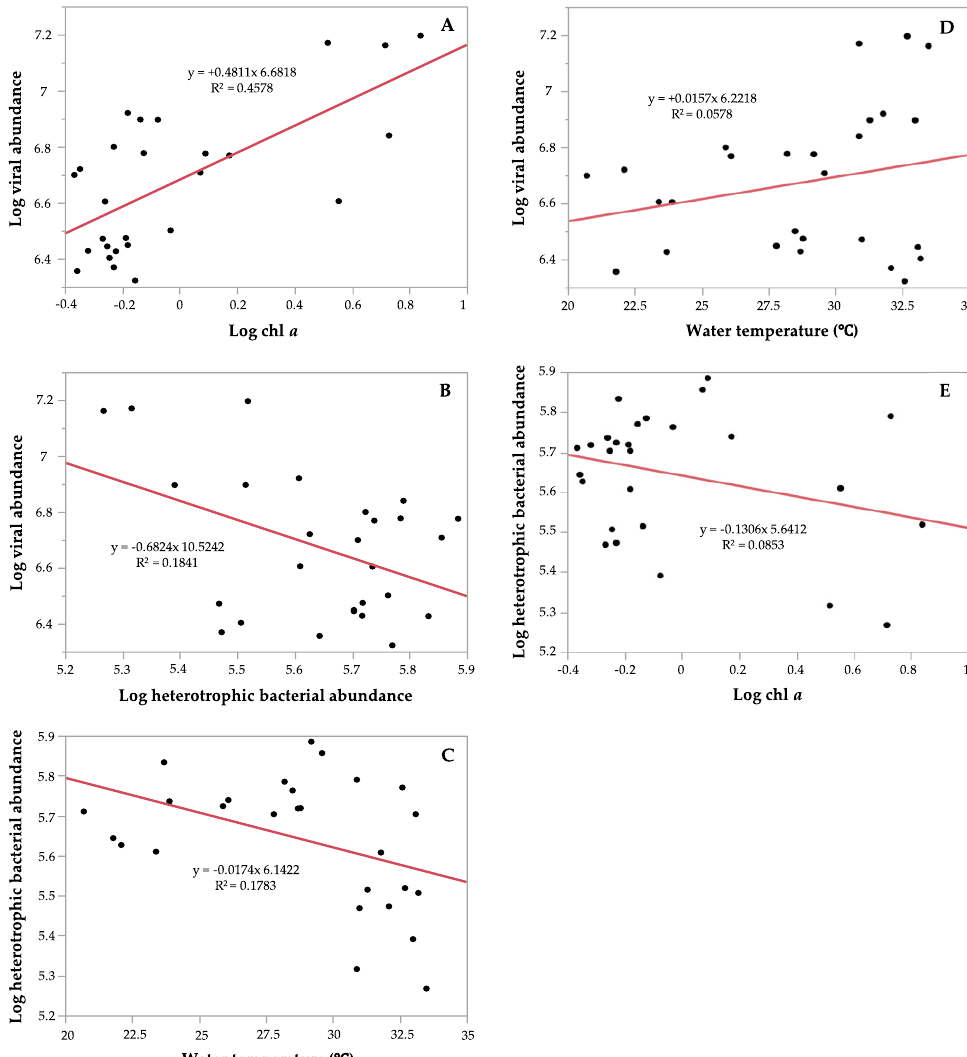
Figure 4. The significant relationships observed between viral abundance with ( A ) Log chl a concentration ( p = 0.0001), and with ( B ) Log heterotrophic bacterial abundance ( p = 0.0255); and between ( C ) Log heterotrophic bacterial abundance with water temperature ( p = 0.0282). No significant relationships between ( D ) Log viral abundance with water temperature ( p = 0.2271), and between ( E ) Log heterotrophic bacterial abundance with log chl a concentration ( p = 0.1394). The red line fits the linear regression.